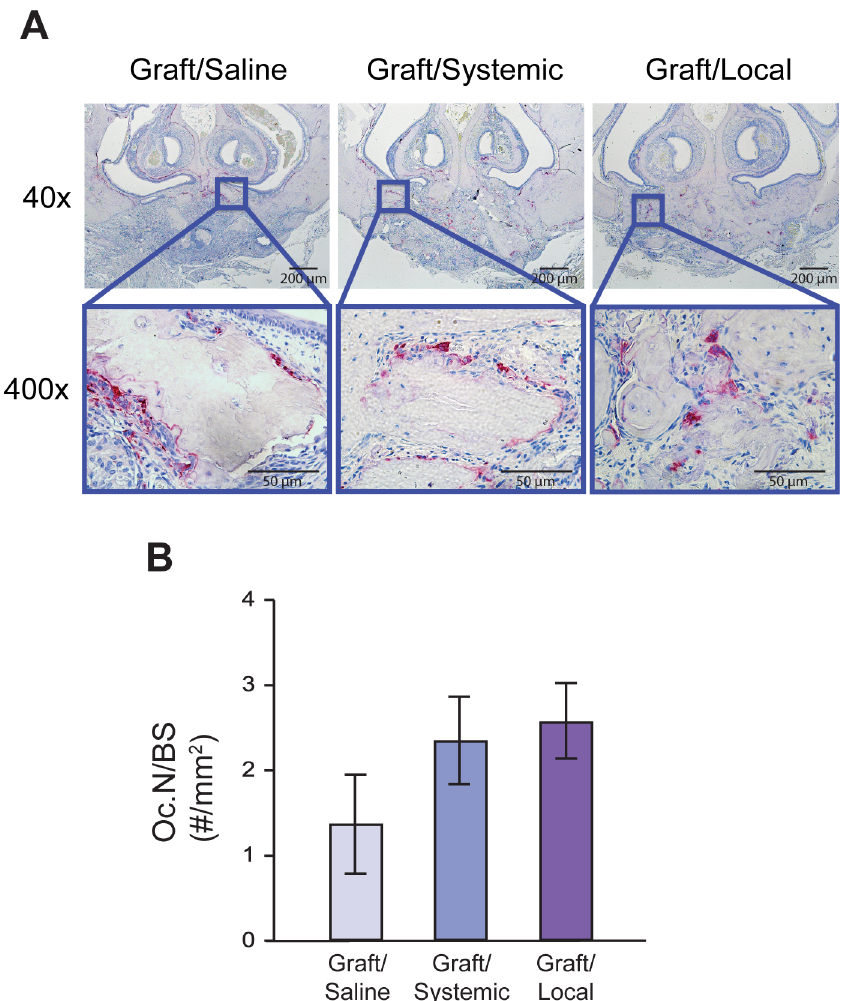
Fig 4. TRAP staining images and quantification. (A) TRAP stainingat 40x and 400x magnification for all three groups. (B) Measurement of the numberof TRAP+ cells per bone surface (Oc.N/BS) for each